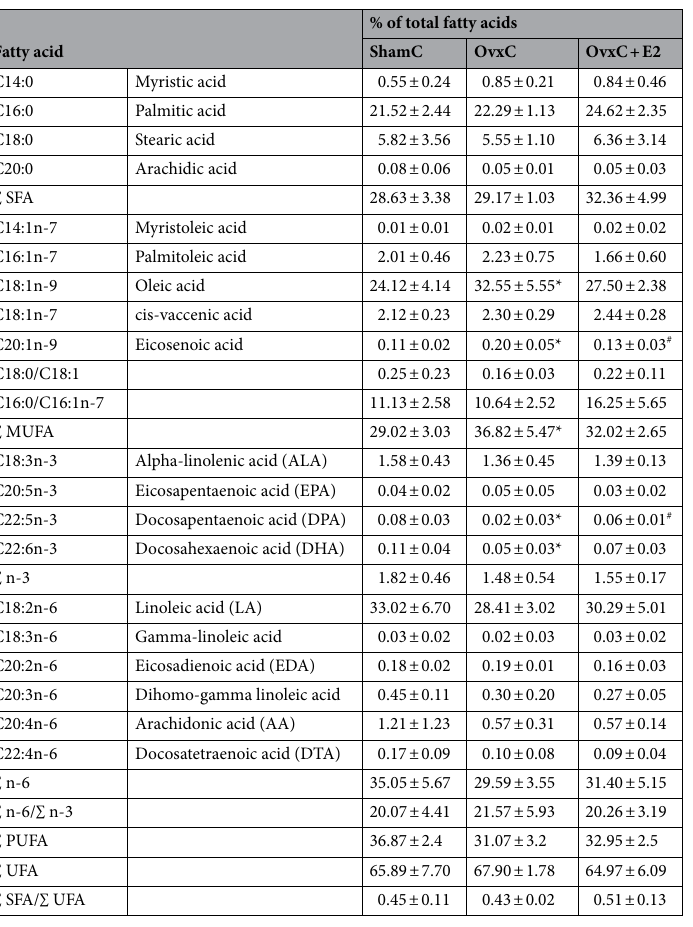
Table 3. Fatty acid composition of RET monoglyceride diglyceride lipids obtained from ovariectomized (Ovx) or Sham operated rats, fed a control (C) diet, subjected or not to oestrogen replacement therapy (E2). Data presented as means ± standard error (SE) of the % of total FAs. n = 6 for each group. SFA saturated fatty acids, MUFA monounsaturated fatty acids, PUFA polyunsaturated fatty acids. *p < 0.05 vs ShamC; #p < 0.05 OvxC vs OvxC +